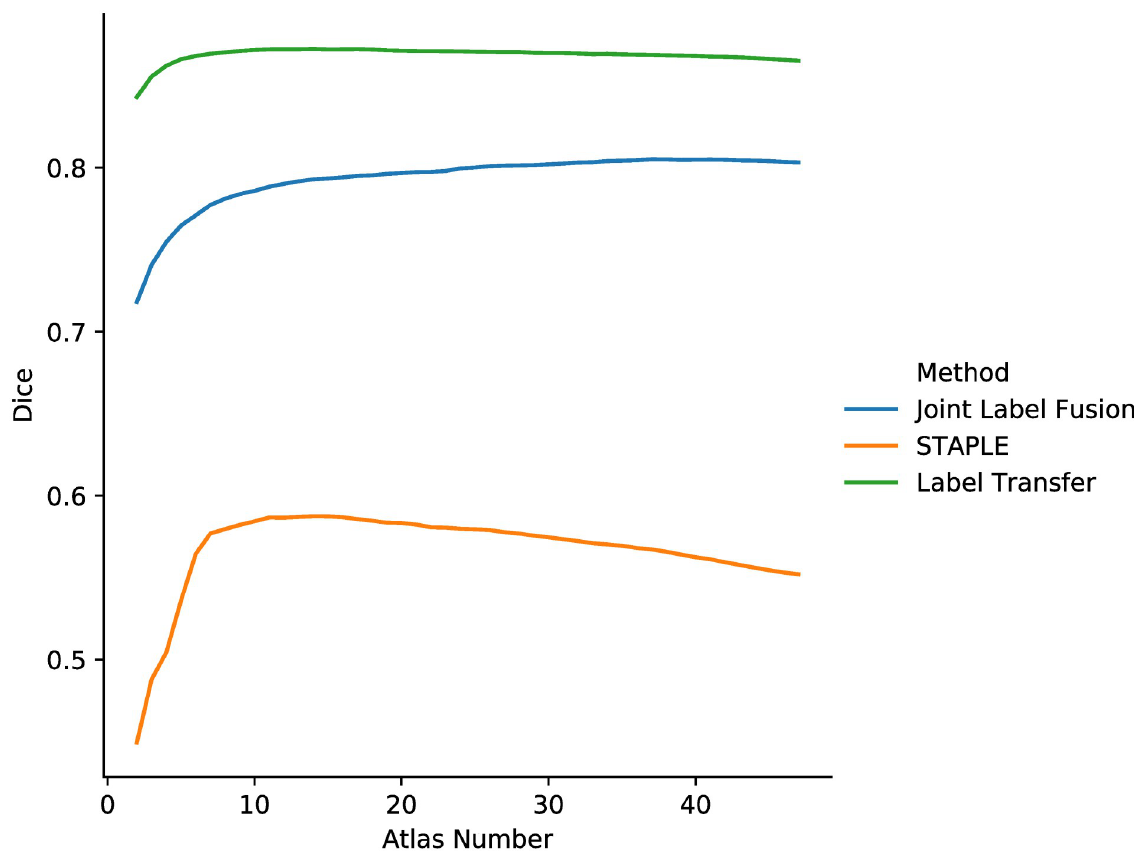
Fig 11. The mean Dice coefficient results of three label fusion methods, Joint Label Fusion (middle), STAPLE (bottom) and the label transfer (top, our method), on the ADNI dataset. The number of selected candidate atlases ranges from 1 to 47.